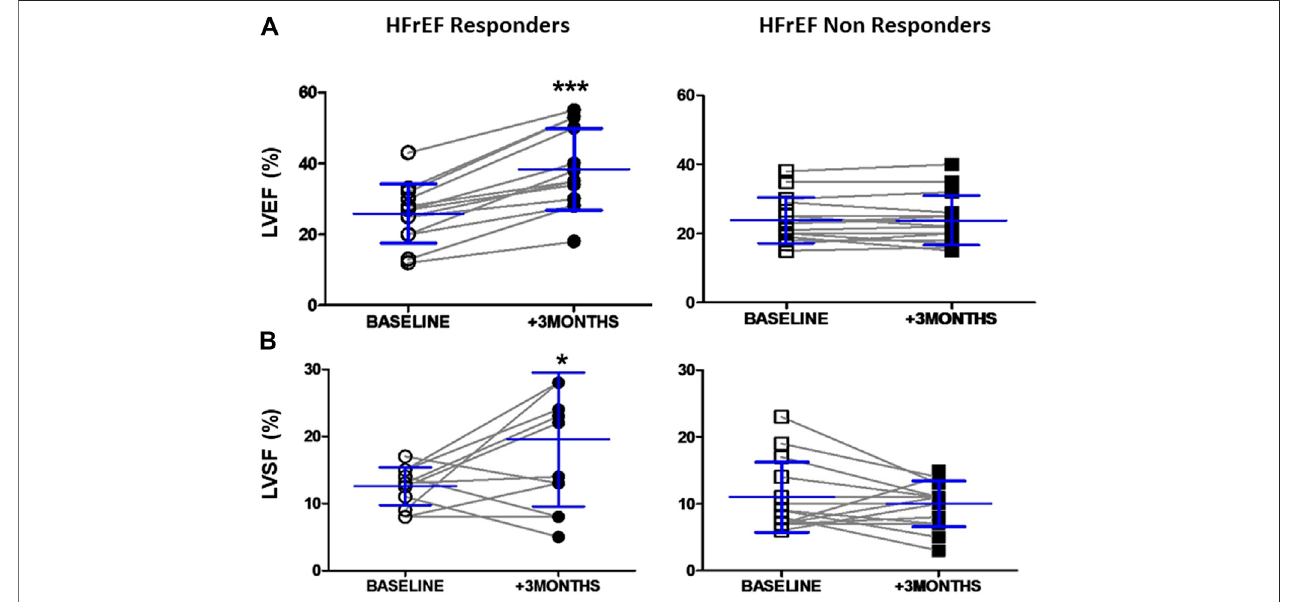
FIGURE2| LVsystolicfunctionbeforeand3 monthsaftercardiacresynchronizationtherapyinrespondersandnonrespondersHFrEFpatients (A) Dotgraphofleft ventricle eyection fraction in responders patients ( n (cid:1) 13, whitecircles (cid:1) baselines and black circles (cid:1) +3 months) and nonresponders patients( n (cid:1) 15, whitesquares (cid:1) baselines and black squares (cid:1) + 3 months) (B) Dot graph of shortening fraction in responders patients ( n (cid:1) 13, white circles (cid:1) baselines and black circles (cid:1) + 3 months) andnonresponderspatients( n (cid:1) 15,whitesquares (cid:1) baselinesandblacksquares (cid:1) +3 months).Datashownasmean ± SD.Symbols:*** (cid:1) p < 0.001;* (cid:1) p < 0.05 (non parametric Wilcoxon Signed Rank Test) vs. baseline, respectively. Abbreviations: EF (cid:1) Ejection fraction, SF (cid:1) Shortening fraction.